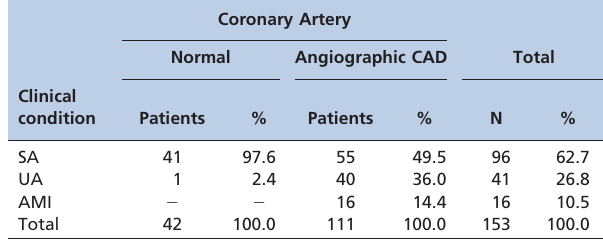
Table 2 - Association between symptoms and the presence or absence of angiographic coronary